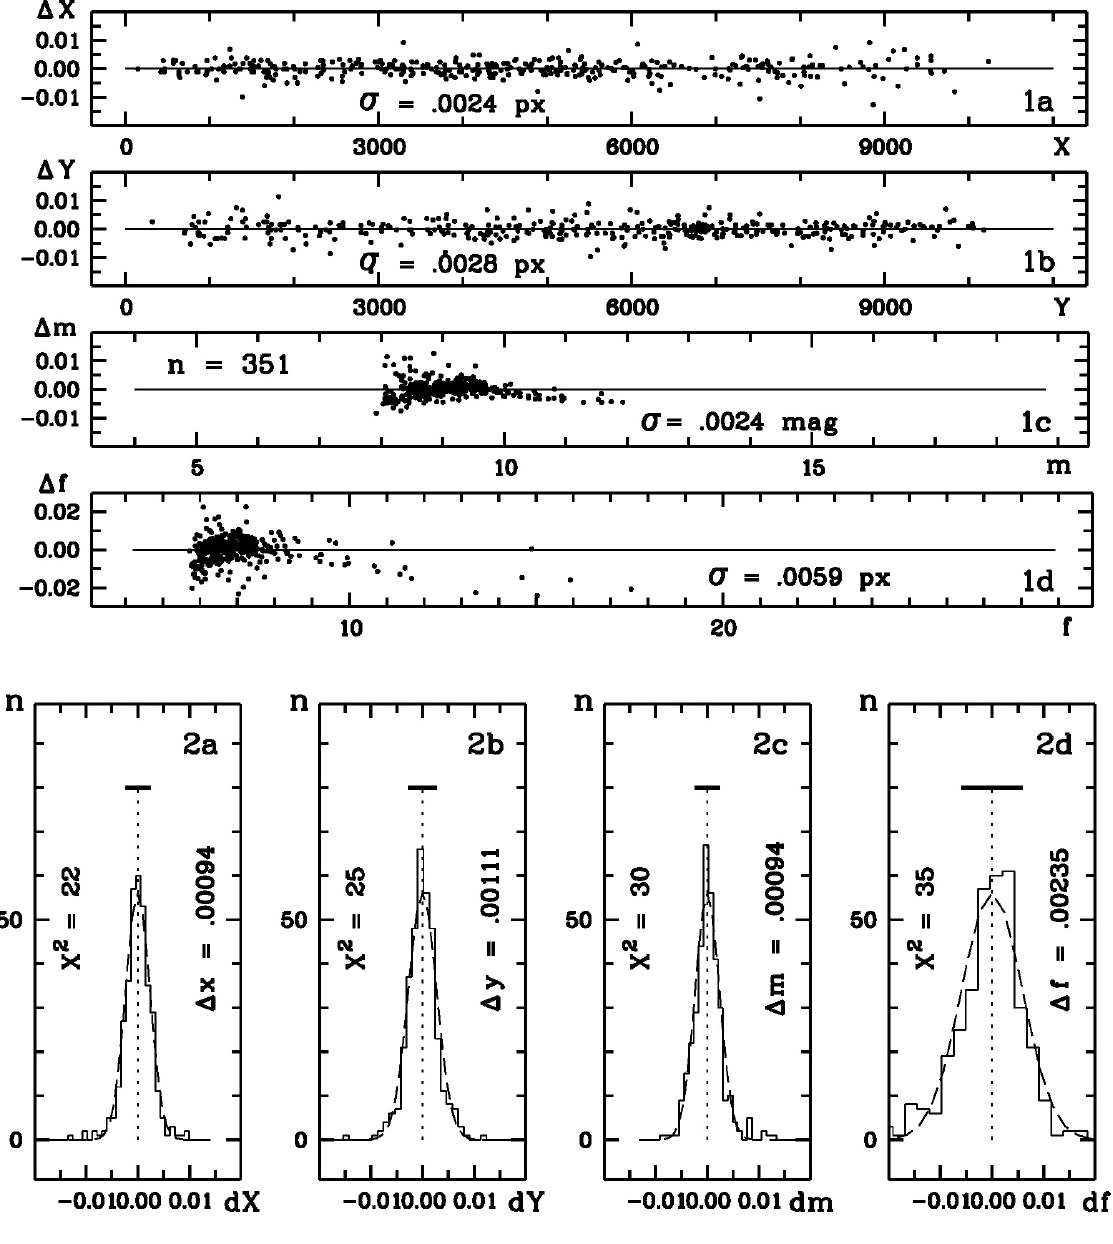
Figure 4. On the top part on the picture the difference between calculated values of gray 8¬bit and 16¬bit are shown for astrometrical (1a, 1b) and photometrical (1c, 1d) star characteristics relatively to the rectangular coordinates of the plate X, Y and instrumental values m, f, (FWHM) relatively. The values of the single difference between two ways of the plates digitizing is provided. On the bottom of the picture 2a, 2b, 2d, 2c the differences are given in the form of real (solid lines) and theoretical (dash lines) distribution functions for the respective intervals. The values of the interval lengths are given ( ∆x , ∆y , ∆m , ∆f ) and the value X 2 is calculated (on the right and on the left respec- tively). The given data is received for the stars in the interval U = 6 m ÷ 13.5 m